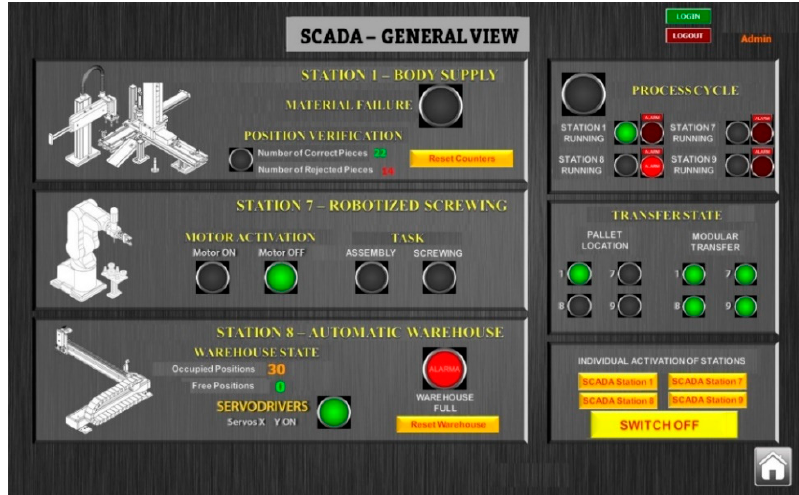
Figure 18. Main view of Monitoring.